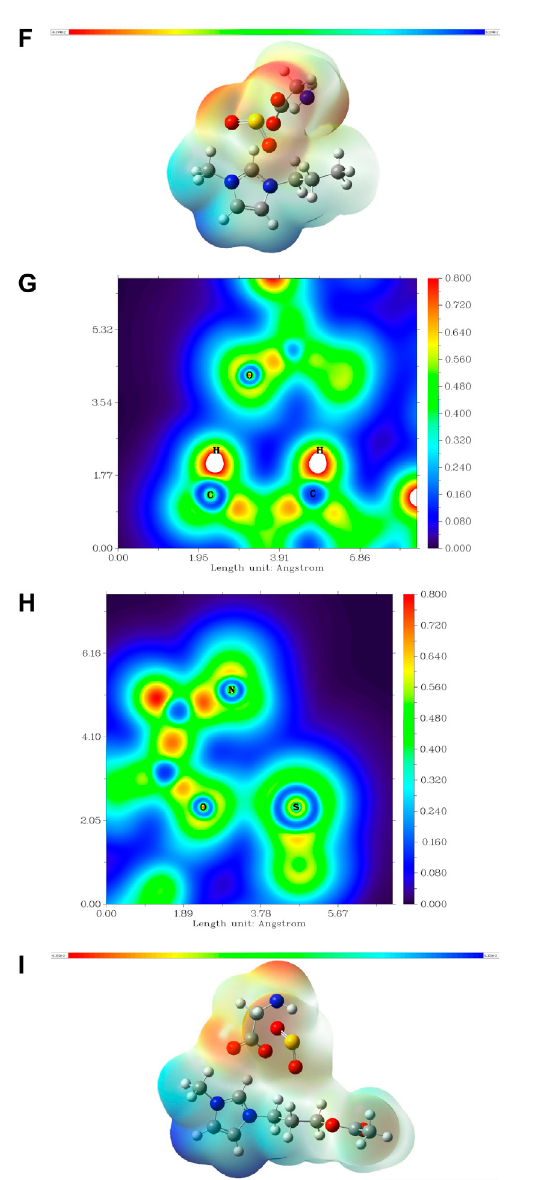
(continued) LOL and ESP analyses of the interaction between the AAILs and SO 2 : (A) LOL of anion and cation in [C 3 MIM][GLY] ... SO 2 complex, (B) LOL of SO 2 and anion of [C 3 MIM][GLY] ... SO 2 complex, (C)